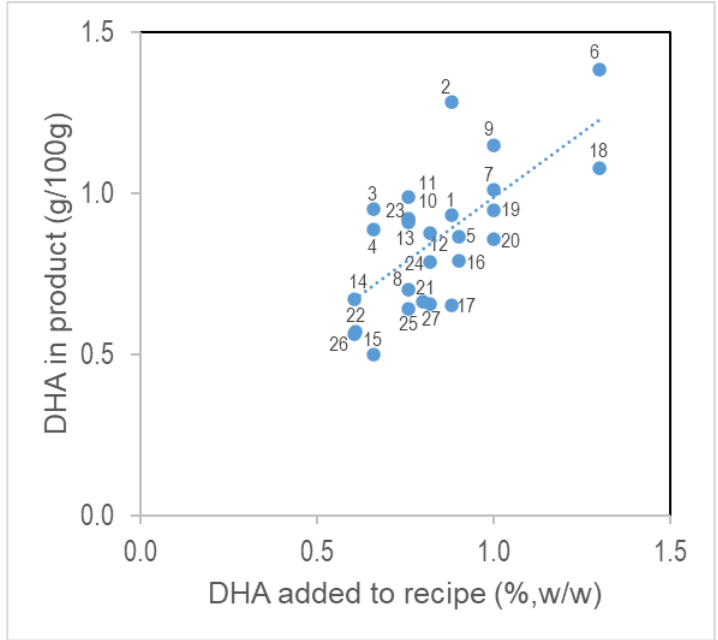
Figure 2. DHA in RUTF. The amount of DHA added to RUTF is linearly related to the amount added. Recipe ingredients for each formulation are in Supplementary Table S4A,B. Recipe ingredients for each formulation are in Supplementary Table